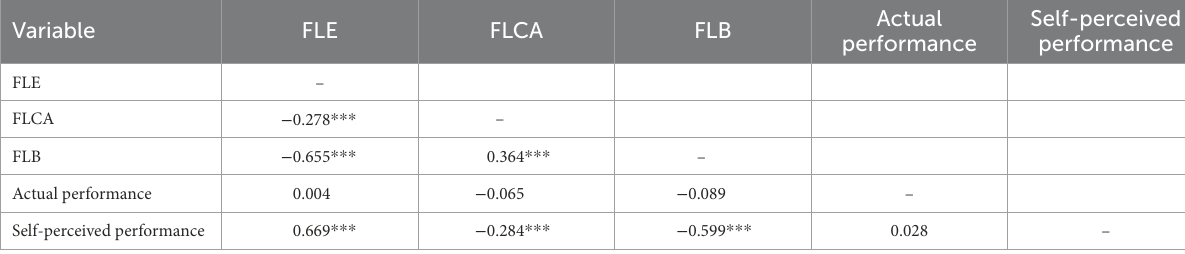
TABLE 4 Correlations between FLE, FLCA, FLB, and online learning performance for speaking group.